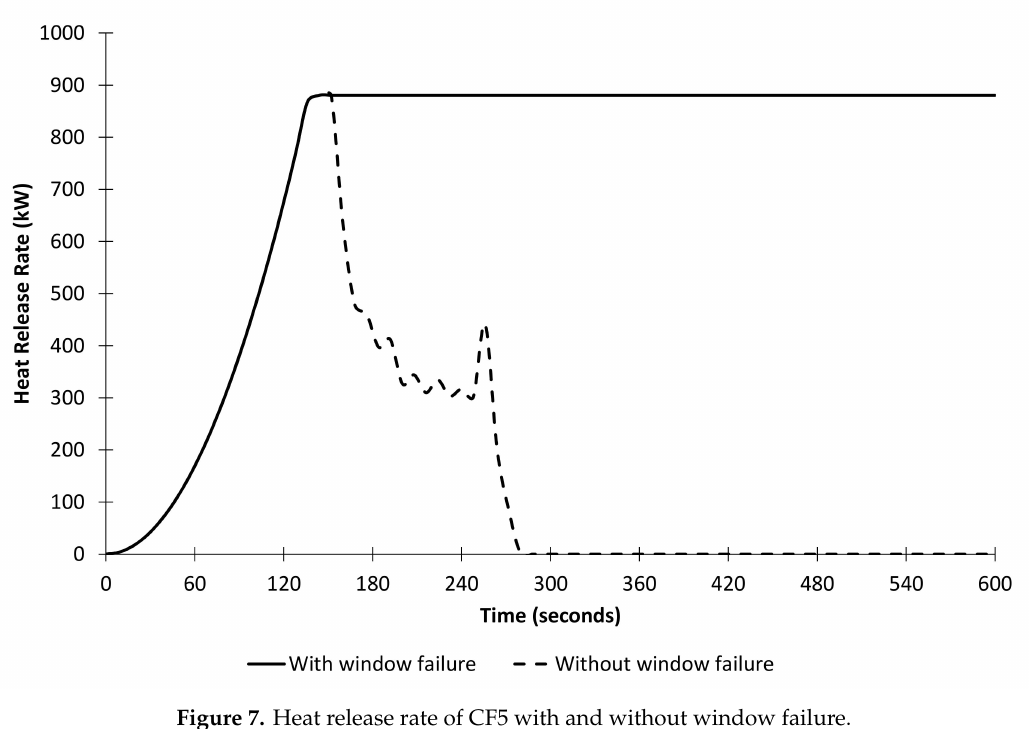
Figure 7. Heat release rate of CF5 with and without window failure.